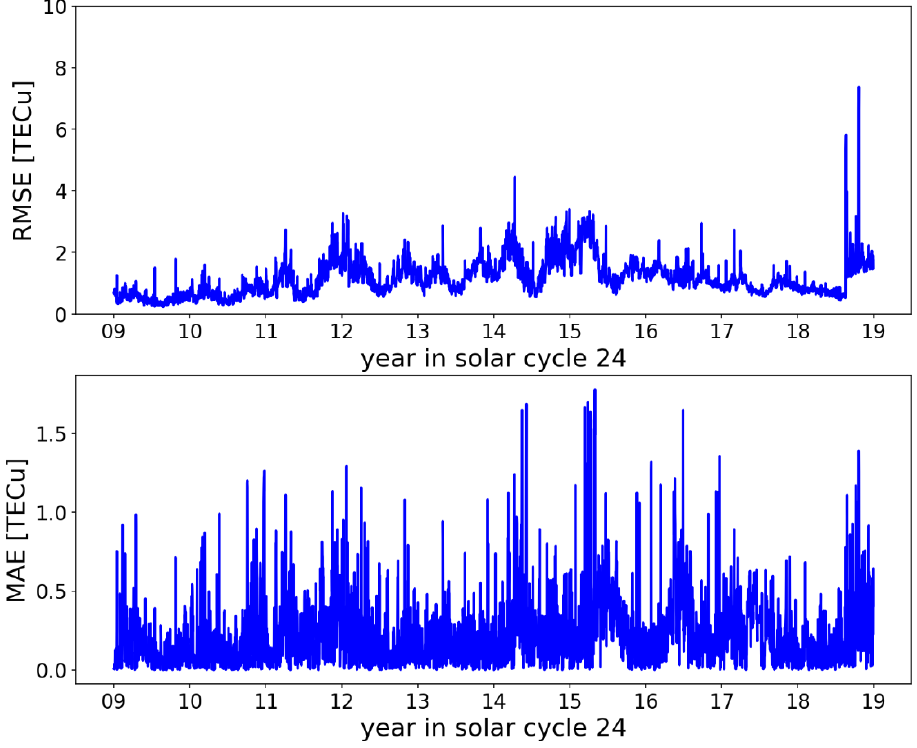
Figure 11. The daily RMSE and MAE for CORG in solar cycle 24.